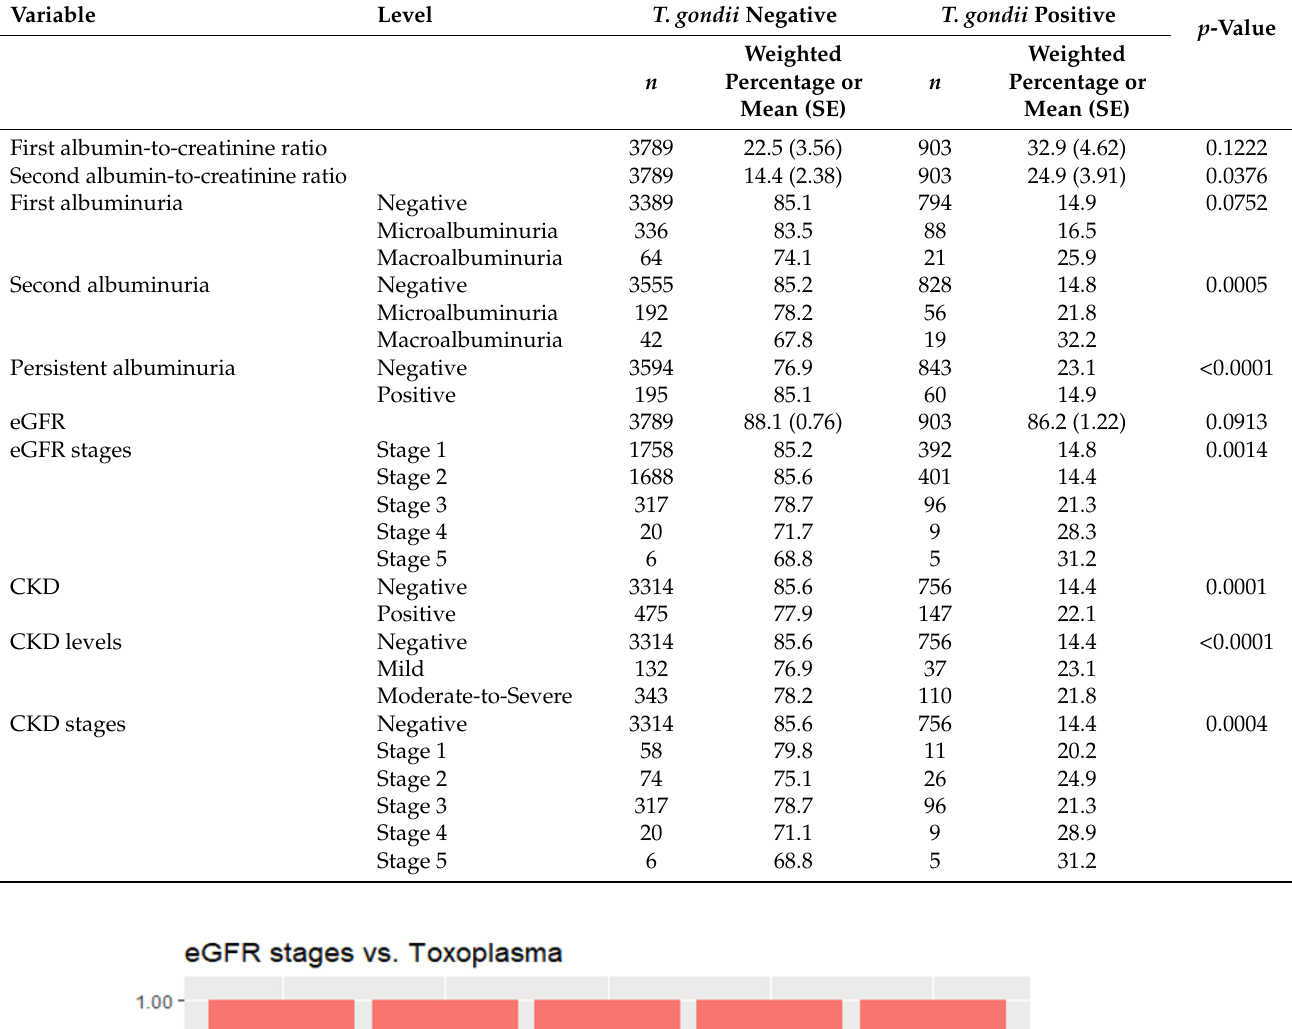
Table 2. Associations between T. gondii (positive/negative) and CKD biomarkers, status, and stages.